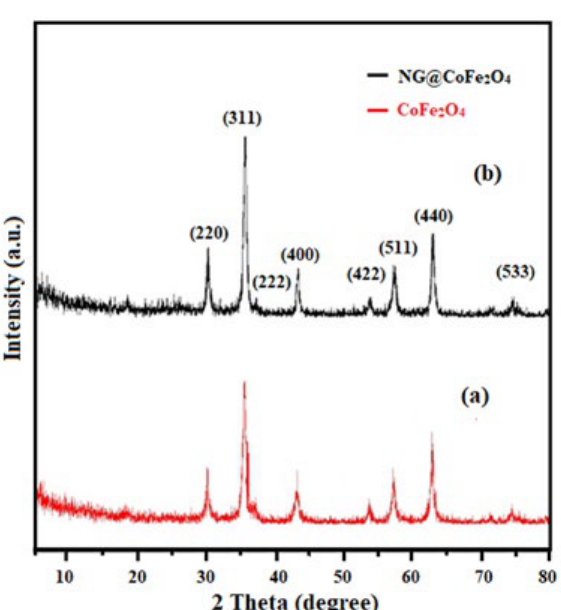
Fig. 3: PXRD pattern of (a) CoFe Fig. 3 PXRD pattern of (a) CoFe 2 O 4, and (b) NG@CoFe 2 O 4